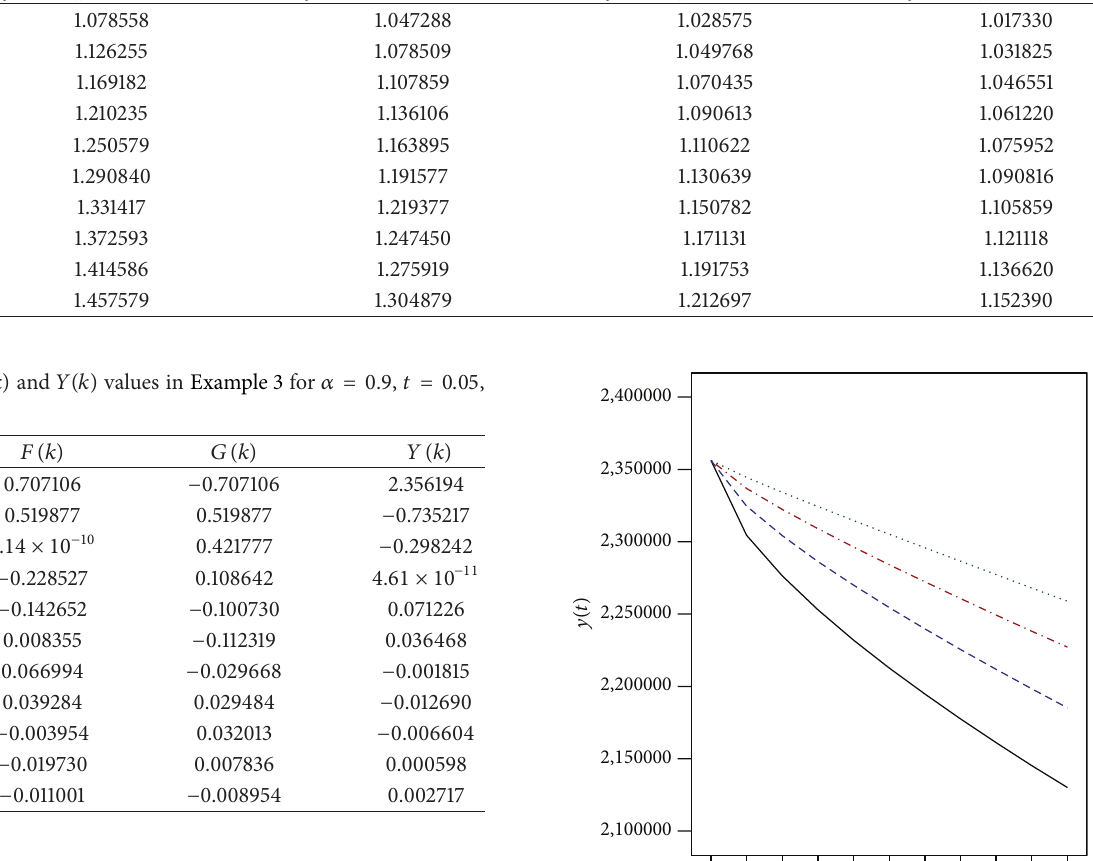
Table 7: 𝑆 𝑛 (𝑡) and |𝑅 𝛼 𝑛 (𝑡)| values in Example 3 for 𝛼 = 0.9 , 𝑡 = 0.05 .